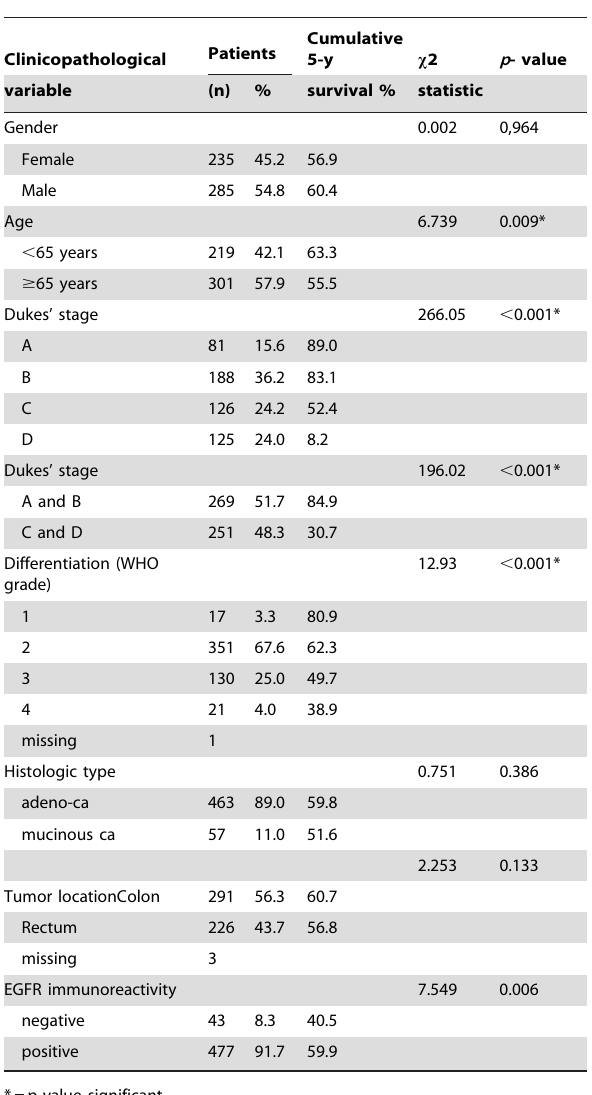
Table 3. Univariate analysis of correlations between preoperative characteristics and survival by Kaplan-Meier life-table and logrank test analyses.